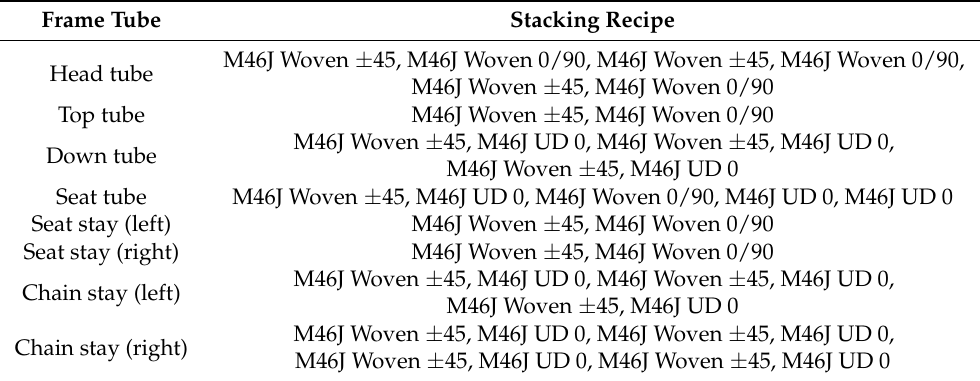
Table 11. Stacking scenario